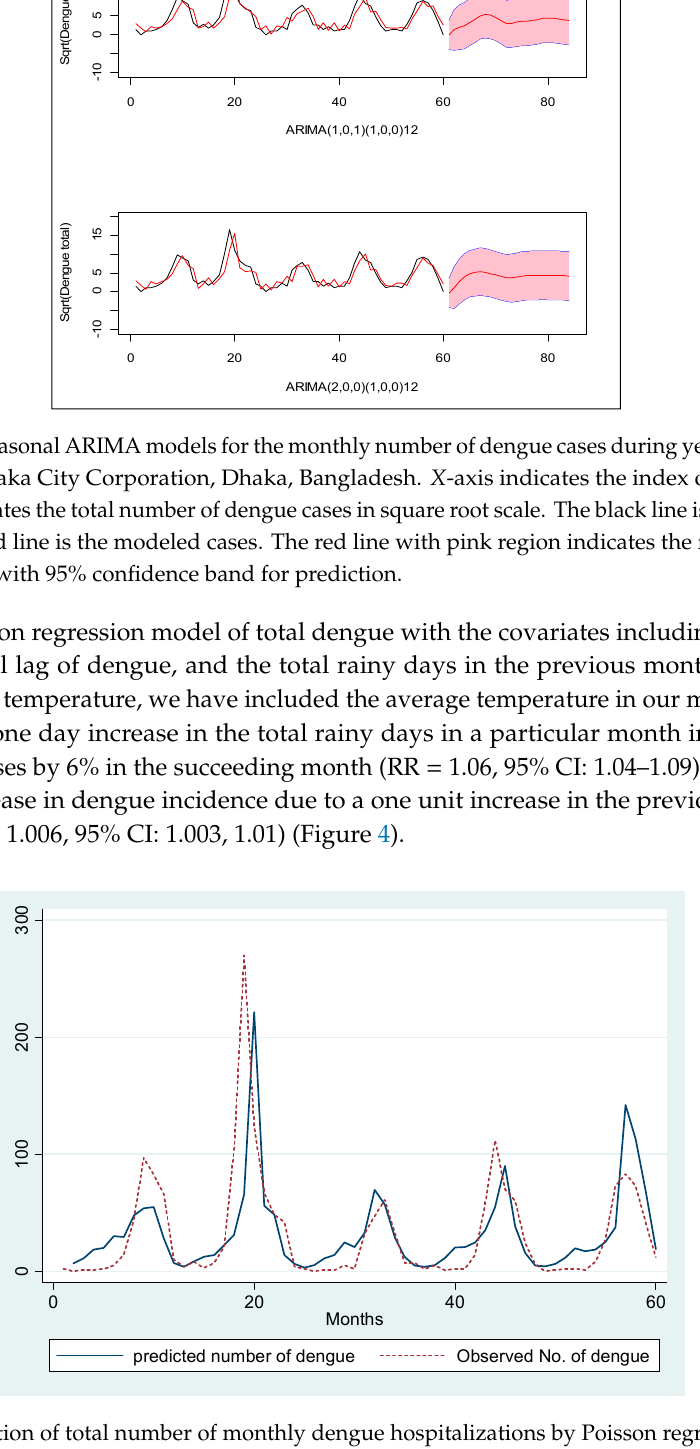
Figure 4. Prediction of total number of monthly dengue hospitalizations by Poisson regression model.